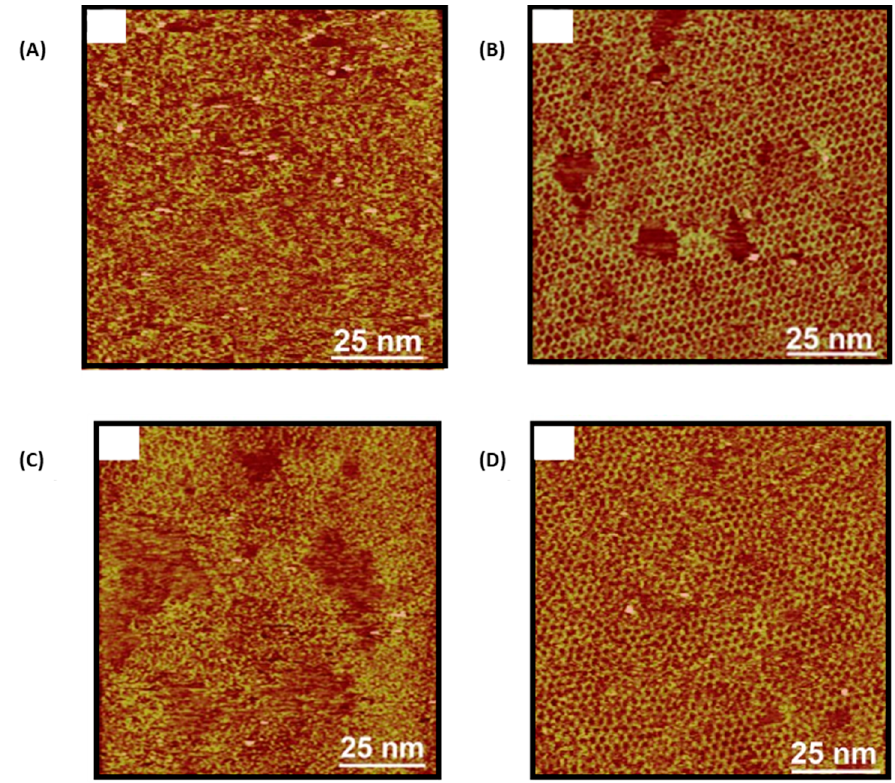
Figure 15. ( A ) STM topograph of the polymerization of 4-formylphenylboronic acid (4FPBA) with 1,3,5- tris (4-aminophenyl)benzene (TAPB) without copper sulfate pentahydrate. ( B ) STM topograph of the polymerization of 4FPBA with TAPB for a reaction carried out at 120 °C for 3 h. ( C ) Stability of the 2D polymer formed with 4FPBA and TAPB after heating at 180 °C for 1 h. ( D ) Stability of the polymer formed from 4FPBA and TAPB after 20 days of storage. Reproduced from [97] with permission from The Royal Society of Chemistry.